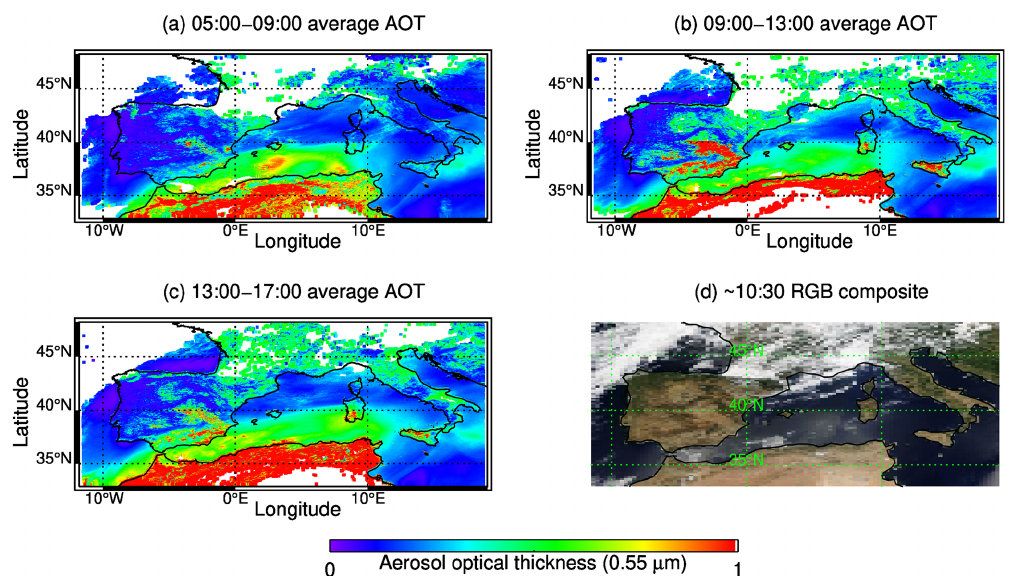
Figure 32. (a–c) Aerosol optical thickness at 0.55µm as retrieved from SEVIRI from 05:00 to 17:00UTC on 11 July 2017, (d) MODIS RGB composite figure showing corrected reflectance at 10:30UTC (https://worldview.earthdata.nasa.gov/, last access: 21 March 2022). The MODIS RGB composite is created combining red, green, and blue bands into one picture. White areas are clouds. The E-EU-03 flight track (in red) is superimposed in panel (d)